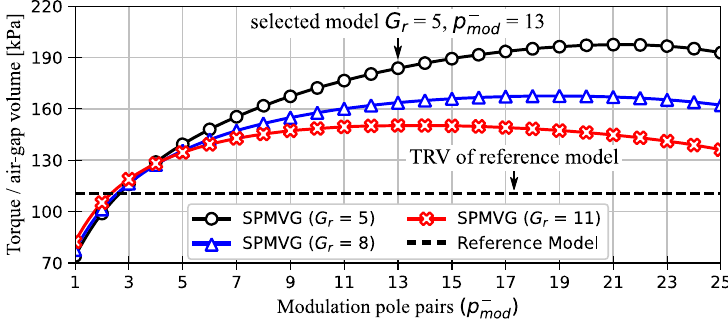
Figure 8. Variation of TRV ( 𝐺 (cid:3045) = 5,8, 11 and 𝑝 (cid:3040)(cid:3042)(cid:3031)(cid:2879) = 1~25